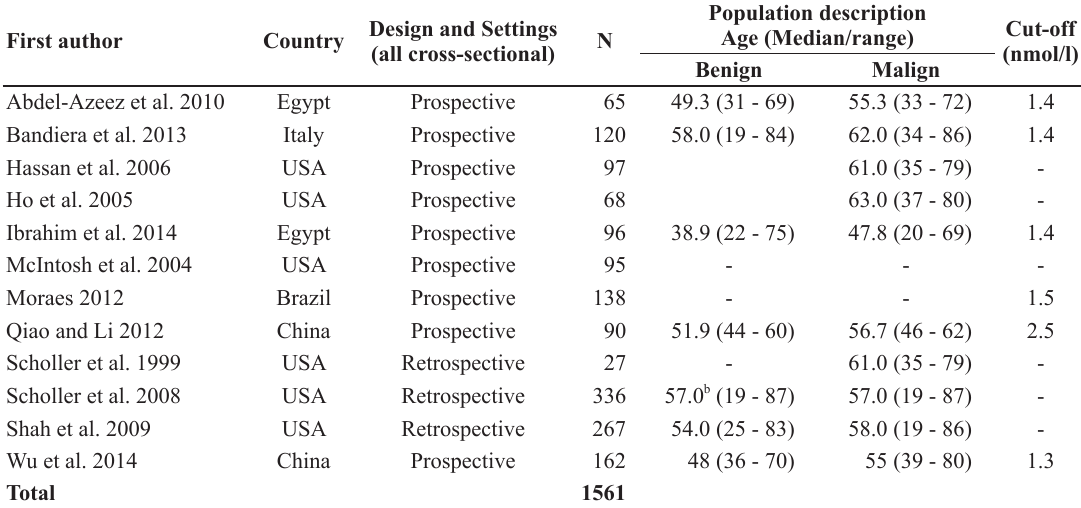
Characteristics of primary diagnostic studies on ovarian cancer diagnosis; all patients had mesothelin level (index test) and histology (reference standard).